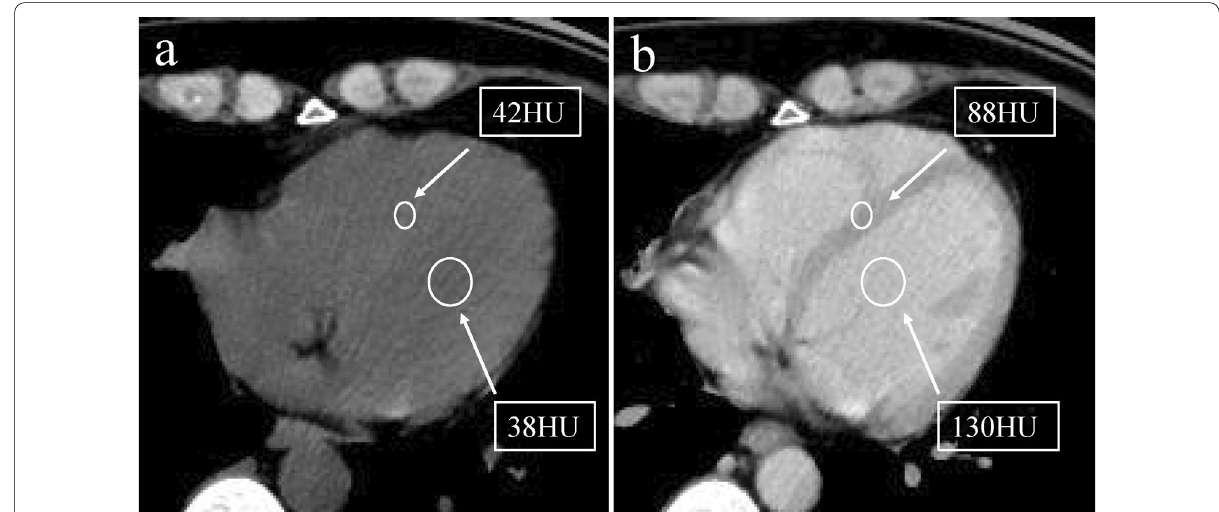
Fig. 2 Region of interest for extracellular volume calculations on computed tomography in a 55-year-old woman with breast cancer. a Contrast-enhanced scan, the ROIs were manually delineated in the middle of the interventricular septum and blood pool avoiding the papillary muscle. b Unenhanced scan, copy the two ROIs in the contrast-enhanced image and place them at similar locations in the unenhanced ventricular septum and blood pool. ROI , region of